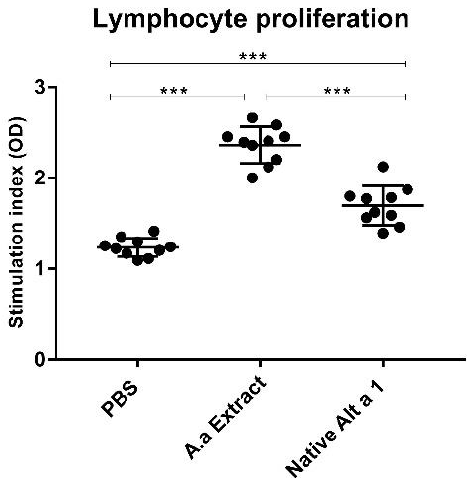
Figure 5. Stimulation index (OD) in lymphocyte proliferation. The OD was calculated as the ratio between the absorbance values of experimental ( A.alternata Extract and nAlt a 1) and control samples (PBS). Significant differences (*** p < 0.001) were observed between the nAlt a 1, the A. a extract and the PBS-instilled mice.